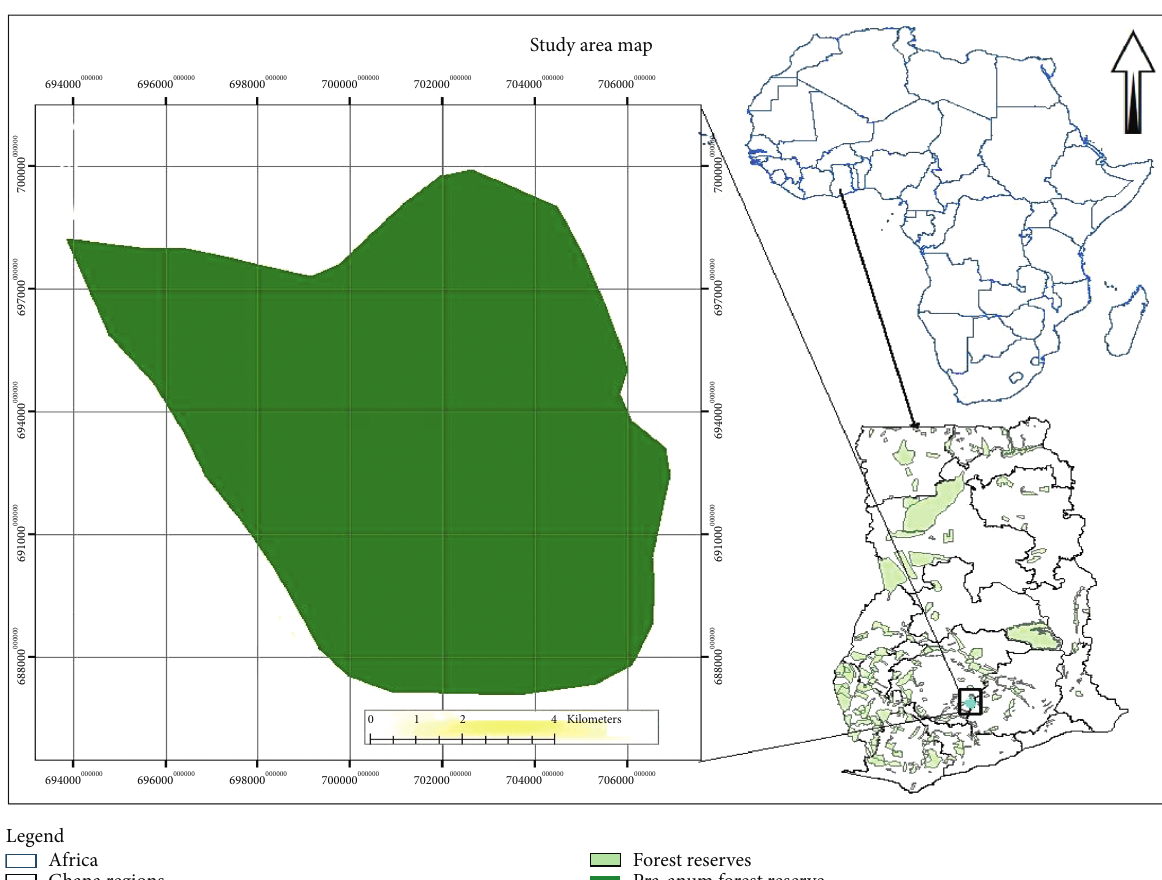
Figure 1: Map of Pra-Anum forest reserve. Source: